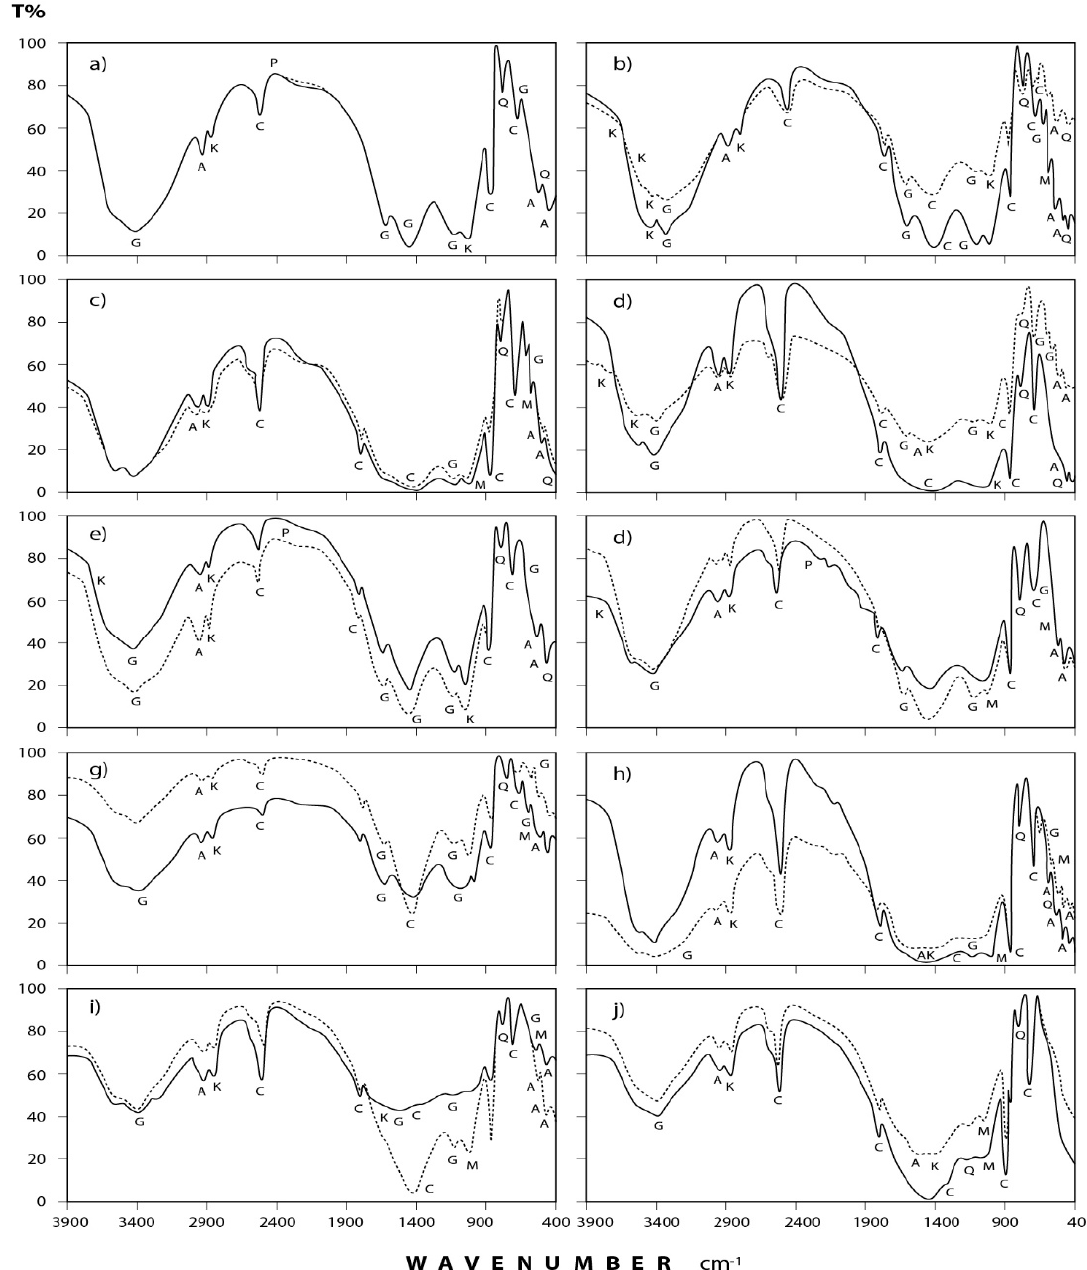
Figure 4. IR spectra of the minerals and organic species detected in annual dust fall samples at Shaq El − Teeban Industral Area during the two years of study. The normal lines represent the first year and bold lines represent the second year: ( a ) North location; ( b ) Northeast location; ( c ) Northwest location; ( d ) South location; ( e ) Southwest location; ( f ) East location; ( g ) West location; ( h ) Center location; ( i ) Office location; ( j ) Workshop location; A = albite; AK = alkane; C = calcite; G = gypsum; K = kaolinite; M = microcline; P = phosphine; Q = quartz.